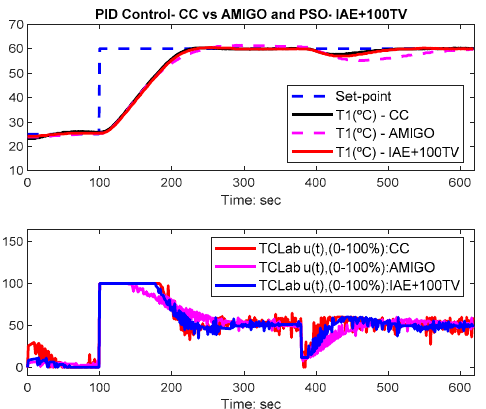
Figure 17. TCLab responses overlapping the responses for Cohen-Coon (CC), AMIGO, and PSO, case IV (J = IAE + 100 TV).